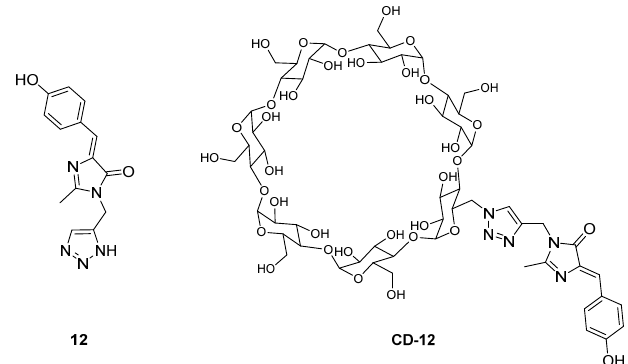
Figure 12. GFPc analogue isolated and attached to a β -cyclodextrin [12].